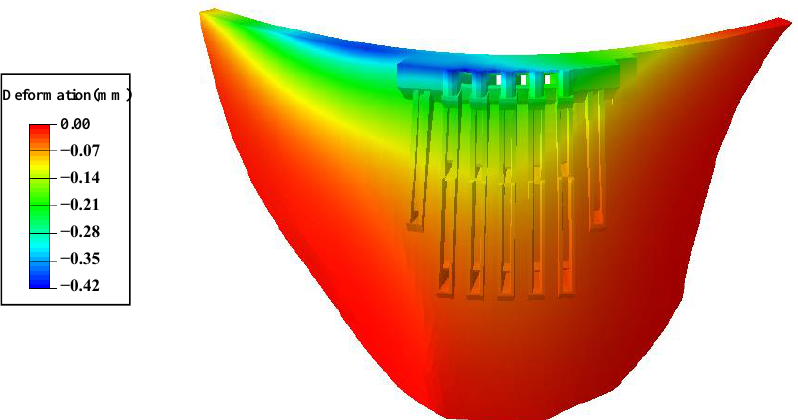
Figure 13. Radial deformation field of the dam caused by solar radiation during a whole day in summer.